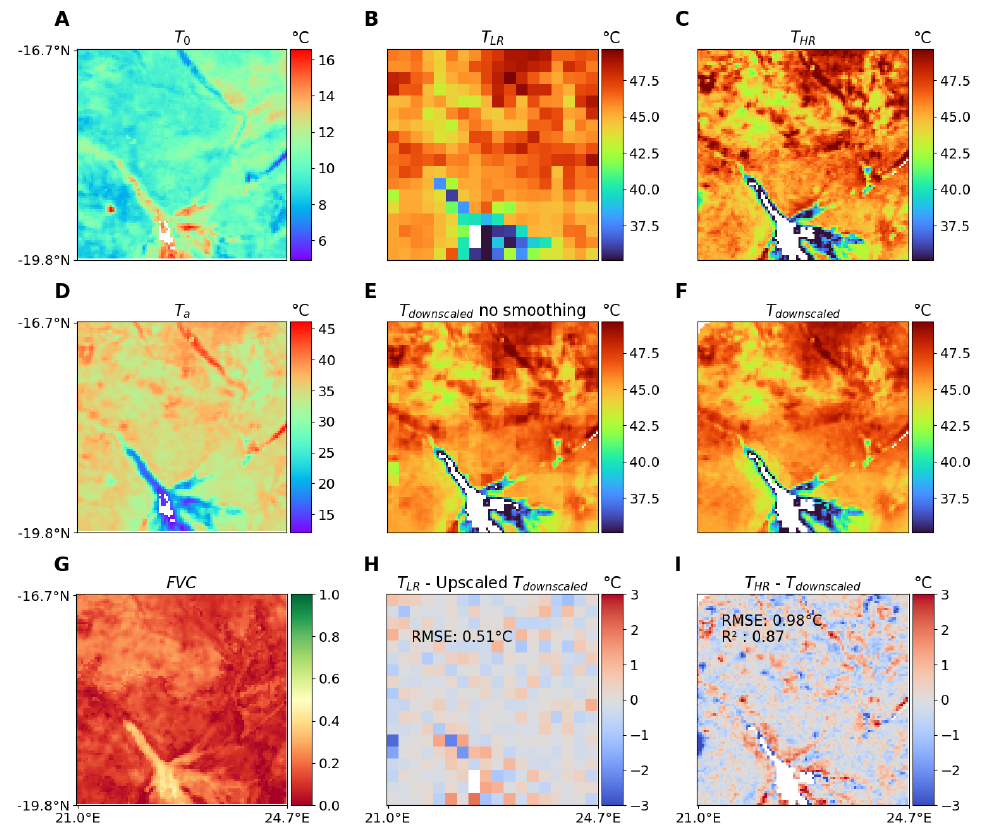
Figure 8. Same as Figure 7, but for 13 August 2016 at